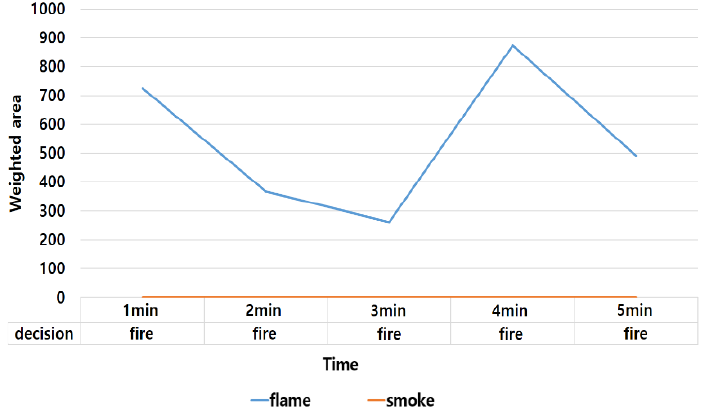
Figure 18. Changes in areas of flame and smoke with final decisions by majority voting for the video clip of Figure 17.